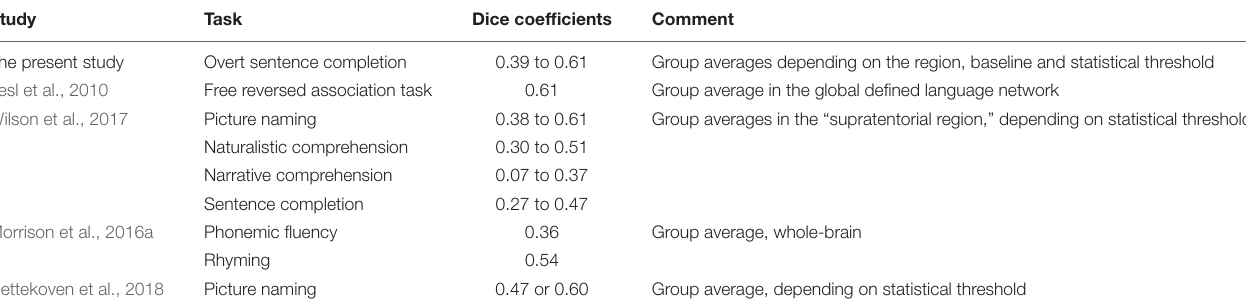
TABLE 3 | Comparison of Dice coefficients to previous fMRI paradigms using language tasks in neurologically healthy